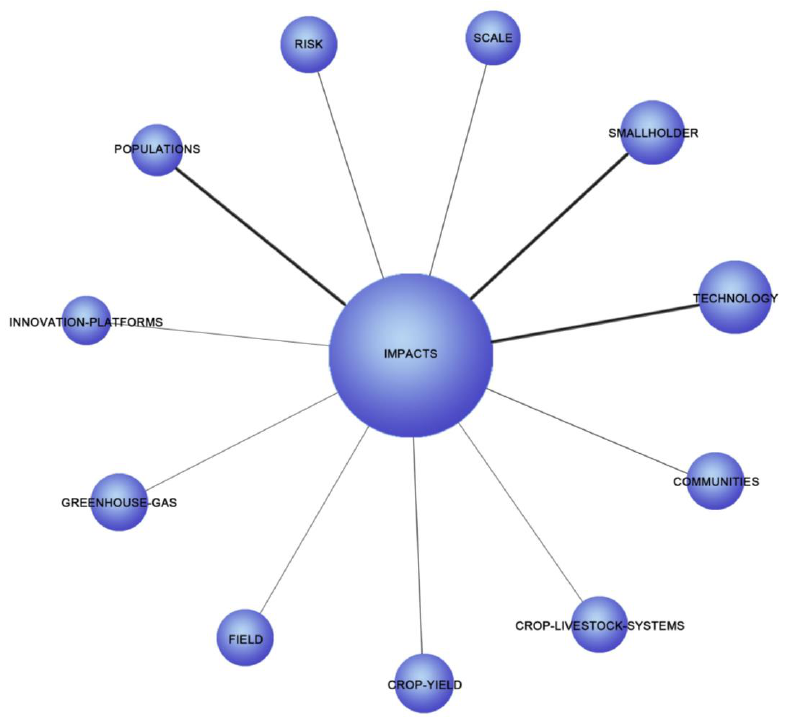
Figure 5. Clustering network diagram of the influencing factors of agricultural sustainable intensification. Data source: Web of Science Core